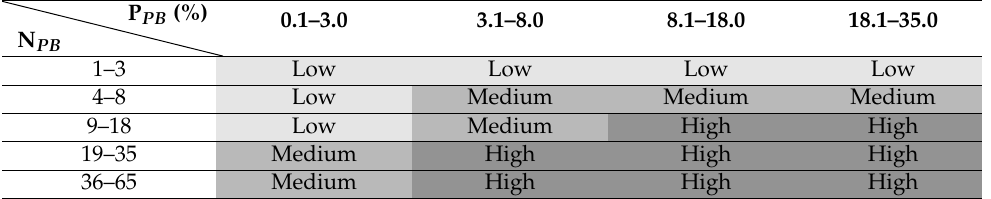
Table 2. Relevance assigned to different combinations of the percentages of photos in the dataset containing stationary bicycles P PB and the number of stationary bicycle detections on photos N PB : low (grey 20%), medium (grey 55%), and high (grey 85%) relevance.